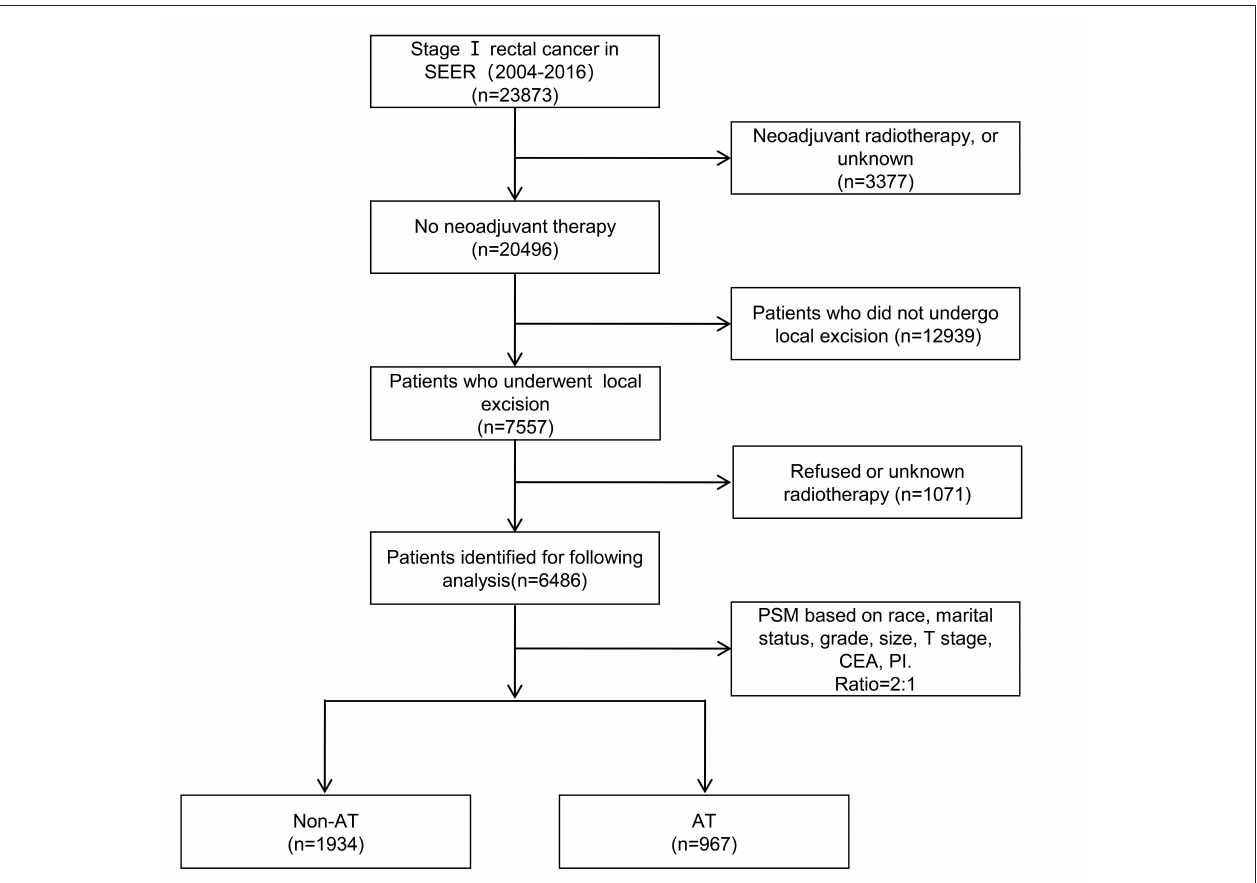
FIGURE 1 | A flowchart of the selection process of included